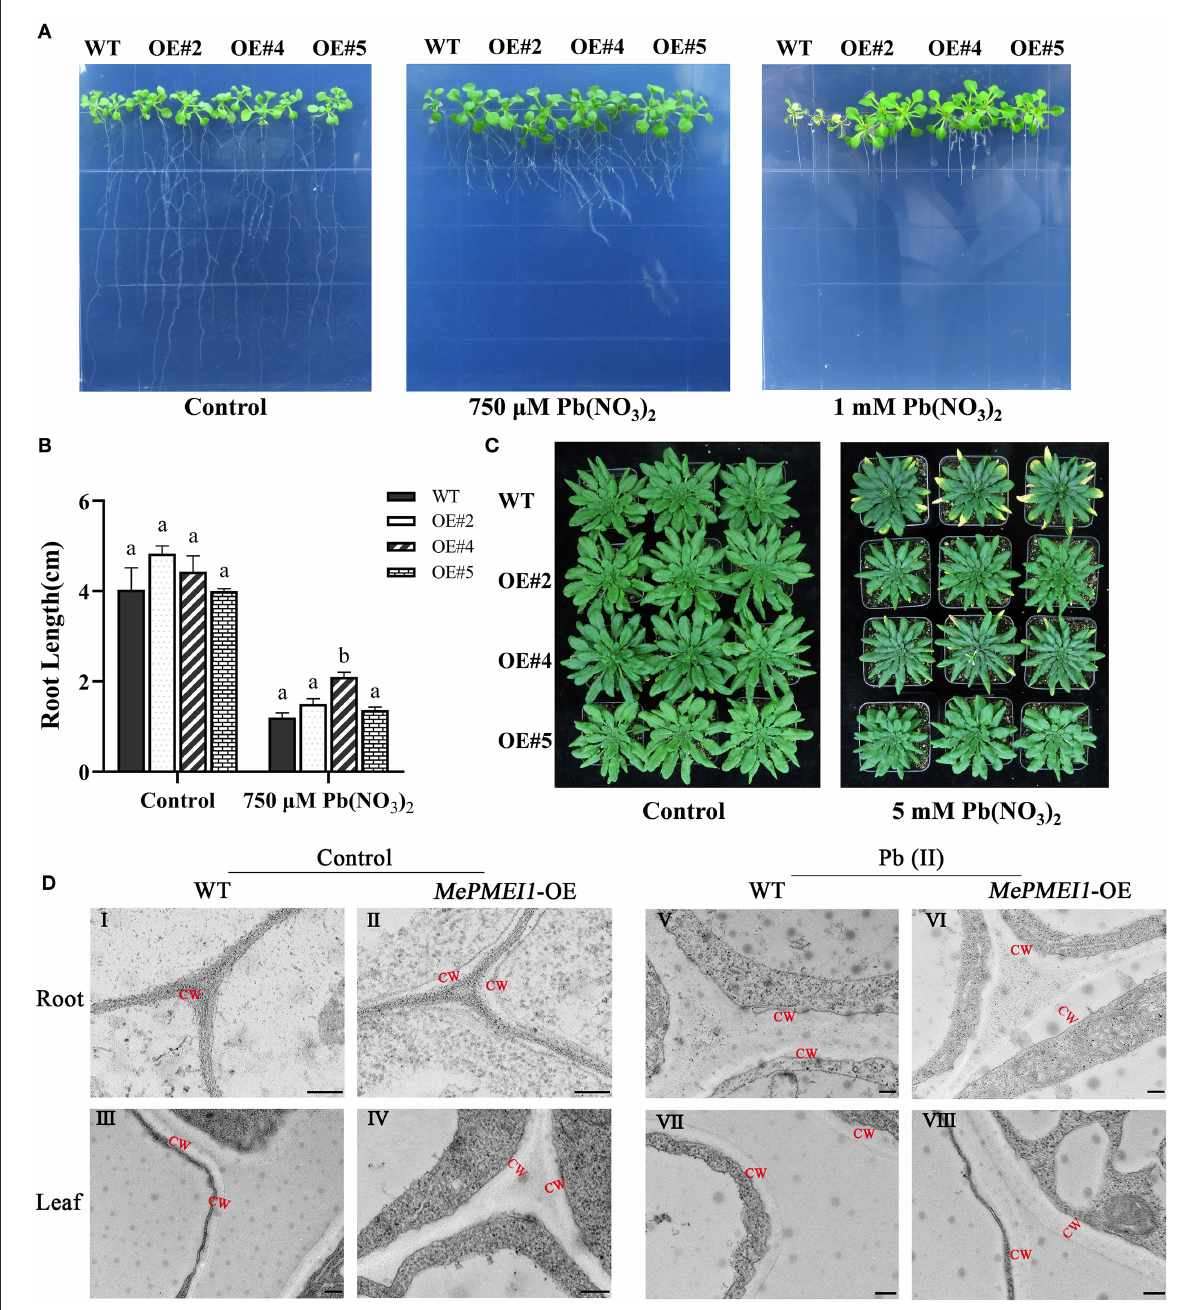
FIGURE5 Resistance assay of Arabidopsis under Pb stress. The growth of the transgenic MePMEI1 and WT plants under control conditions or following treatment with Pb(NO 3 ) 2 when grown on (A) 1/2MS agar medium for 14 days or (C) vermiculite for 16 days. (B) Statistical analysis of the length of plant roots. The data are presented as the mean ± SEM of observations from three biological replicates. The different letters indicate significant differences at the 0.05 level (Duncan test). (D) The structure of the cell walls in root tips (I, II, V, and VI) and leaves (III, IV, VII, and VIII) of transgenic MePMEI1 and WT Arabidopsis under control conditions (I–IV) and following treatment with 750 µ M Pb(NO 3 ) 2 (V–VIII) for 14 days as observed by TEM. CW: cell wall. Scale bars = 200nm.